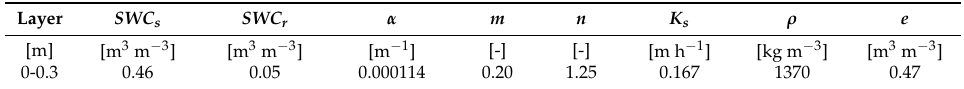
Table 1. Soil physical properties of the layer 0–0.3 m (legend: saturated, SWC s , and residual, SWC r , soil water content; van Genuchten fitting parameters α , m and n ; saturated hydraulic conductivity, K s , soil bulk density, ρ , and porosity, e